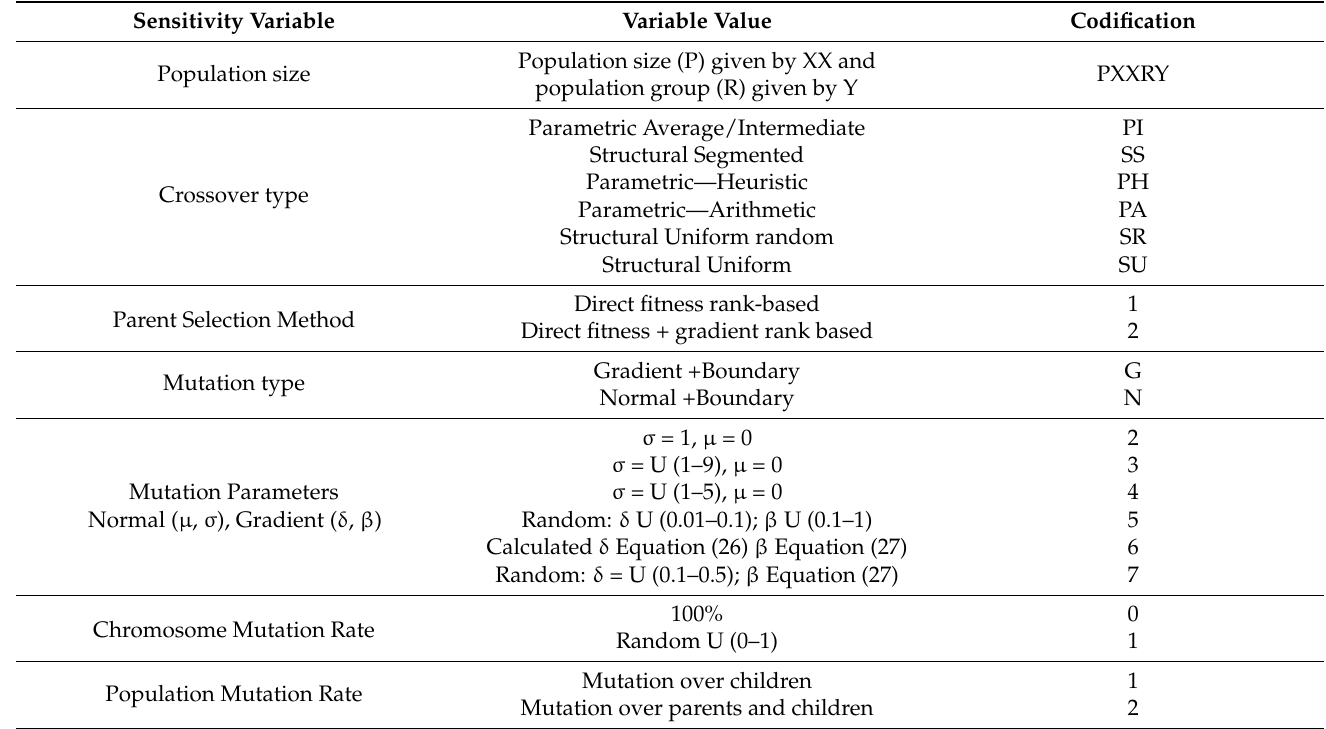
Table 7. Sensitivity settings and case analysis definition.